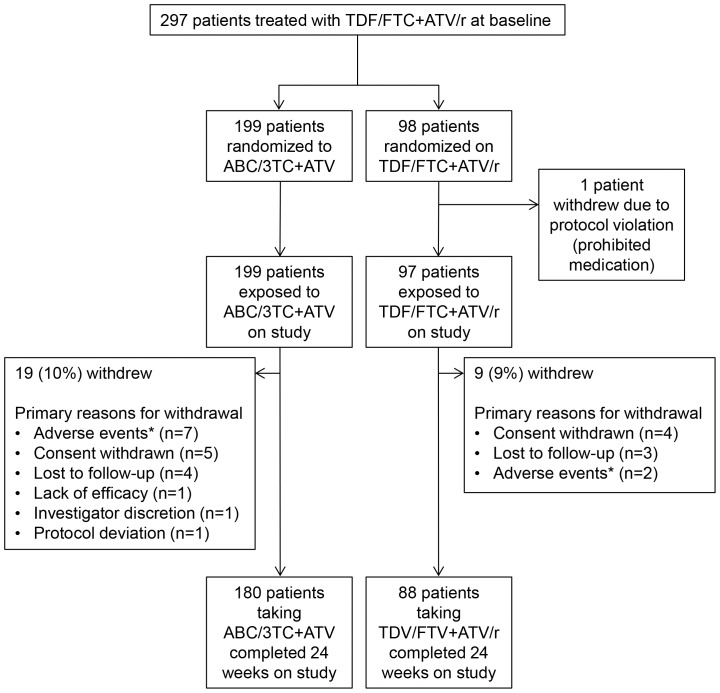
Patient disposition.Primary reasons for withdrawal were listed by the investigator on the case report form. *All adverse events leading to study discontinuation were grade 1 or 2, with the exception of a grade 3 lipase increase in one patient continuing on TDF/FTC+ATV/r.